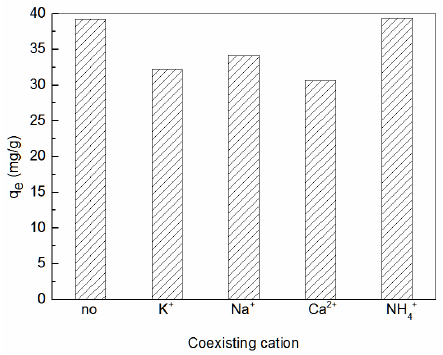
Figure 6. Effect of coexisting anion on the adsorption of Zn 2+ by amidoxime ‐ modified polyacryloni ‐ trile/fly ash composite.